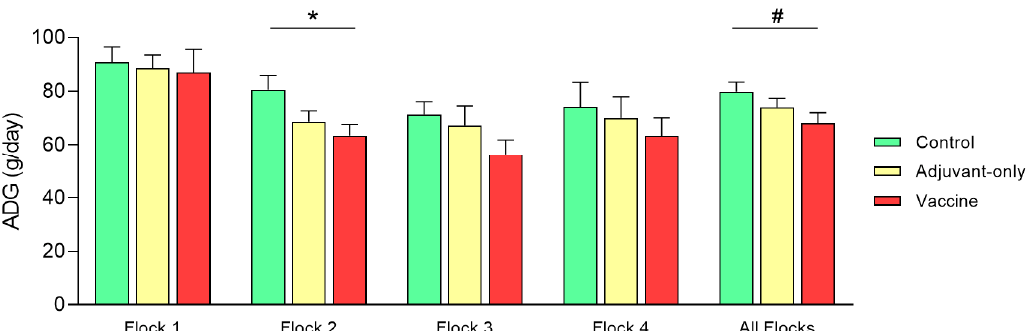
Figure 2. Global average daily gain (ADG) along the experiment in Control (green), Adjuvant-only (yellow), and Vaccine groups (red), both in each individual flock and in all flocks grouped together (All Flocks). Data represented as mean and Standard Error. *: statistical significance ( p < 0.05); #: statistical tendency ( p ≤ 0.1).